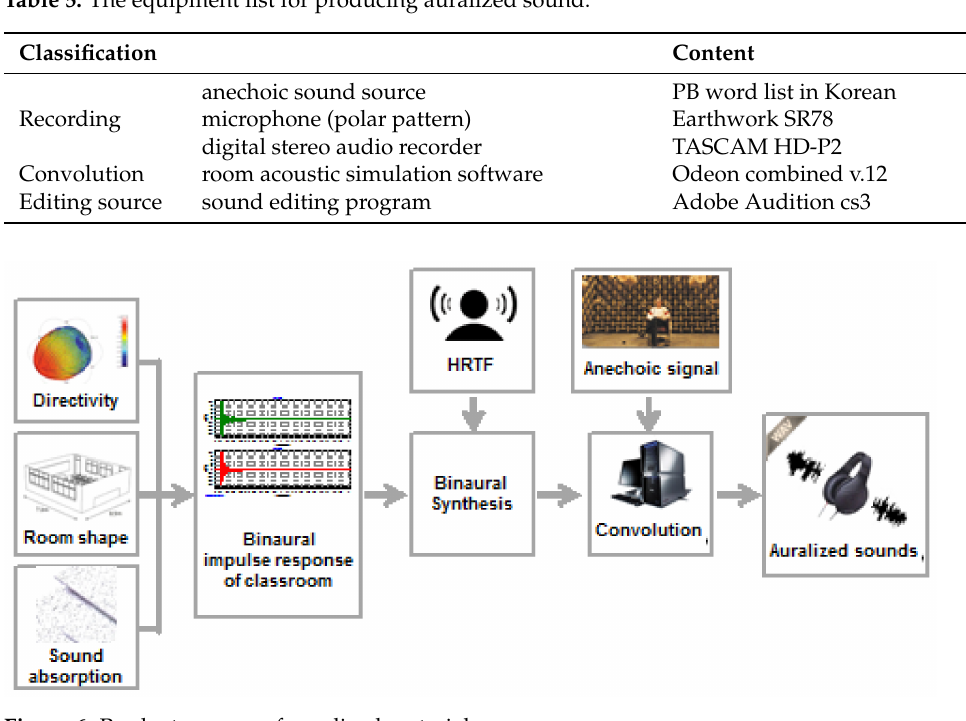
Figure 6. Product process of auralized